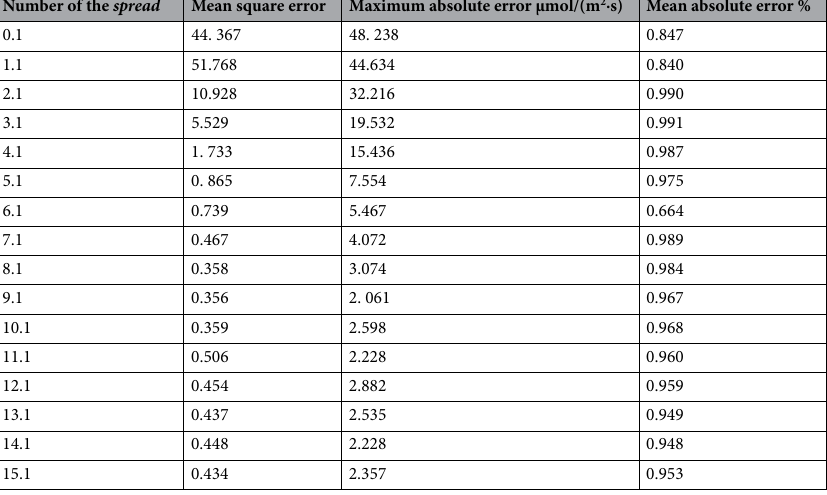
Table 1. Effect of the spread on model